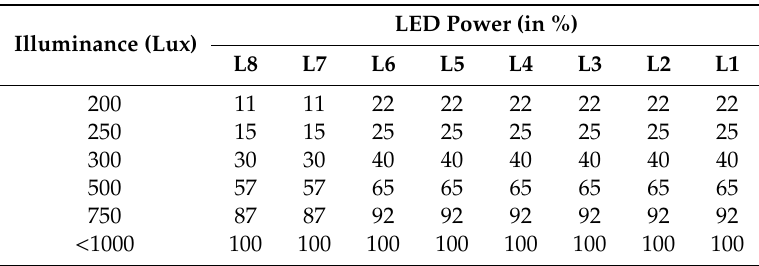
Table 3. Simulation results from sub-scenario A, 6:00 a.m., 1 May 2019.